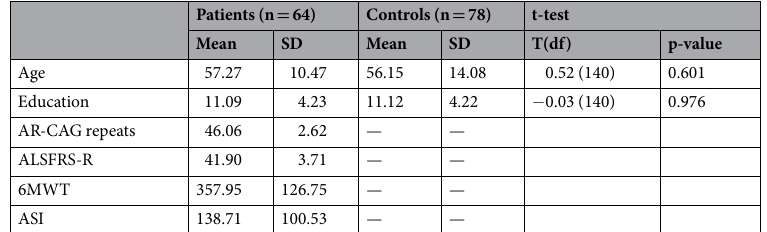
Table 1. Demographic indexes and main clinical features of the studied populations. Age and education are expressed in years; AR-CAG: androgen receptor-cytosine adenine guanine; ALSFRS-R: amyotrophic lateral sclerosis functional rating scale - revised; 6MWT: 6-minute walking test, expressed in meters; ASI: Androgen Sensitivity Index, expressed in U * nmol/L 2 ; SD: standard deviation.